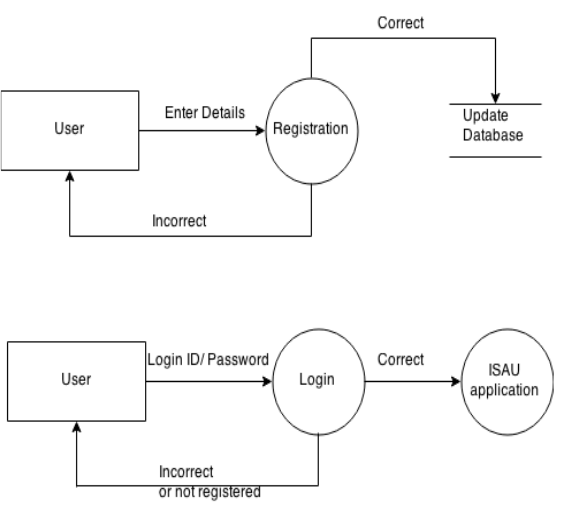
Figure 9. Level 1 DFD for user